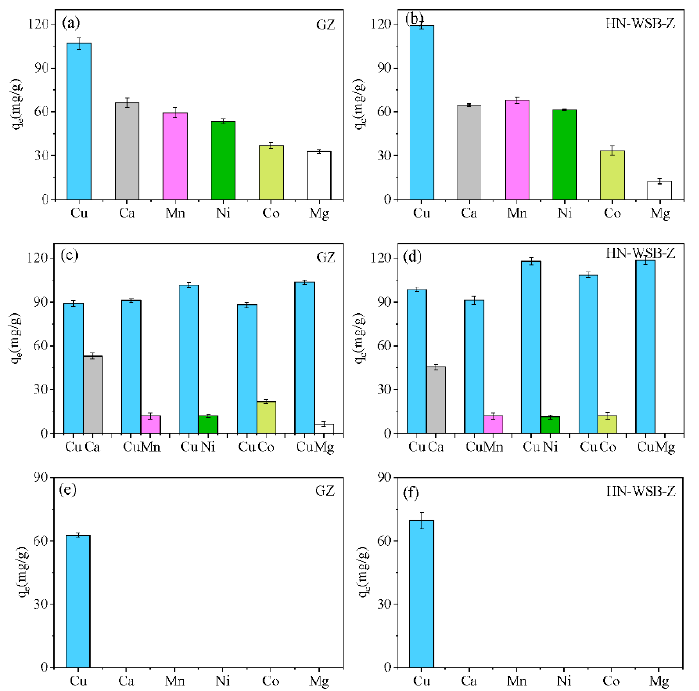
Figure 7. Adsorption capacities of GZ and HN-WSB-Z on Cu(II), Ca(II), Mn(II), Ni(II), Co(II) and Mg(II) in single presented solution ( a , b ), Cu(II)-containing two-component metal-ion solution ( c , d ), multicomponent metal-ion coexisting solution ( e , f ). (Conditions: T = 298 K, t = 180 min, C 0 = 20 mg/L, dosage = 0.2 g/L).